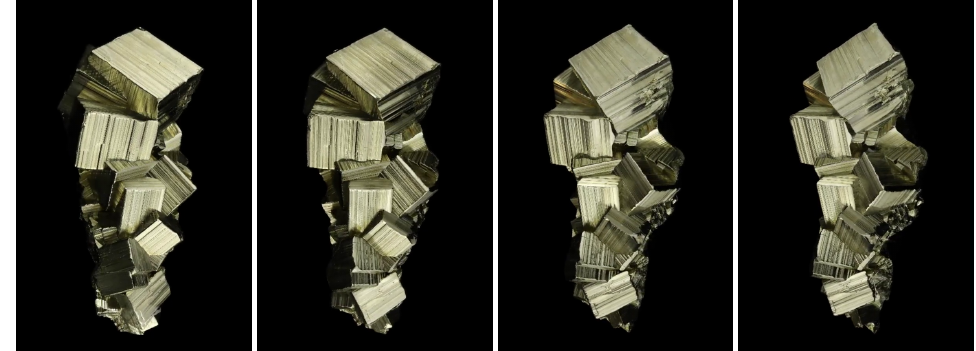
Figure 2. Rendered views of a pyrite mineral we recreated in VR (from original photographs of the mineral by: MINES ParisTech Mineralogy Museum/E. Gaillou). The virtual object displays view-dependent highlights where light was captured bouncing off the mineral’s